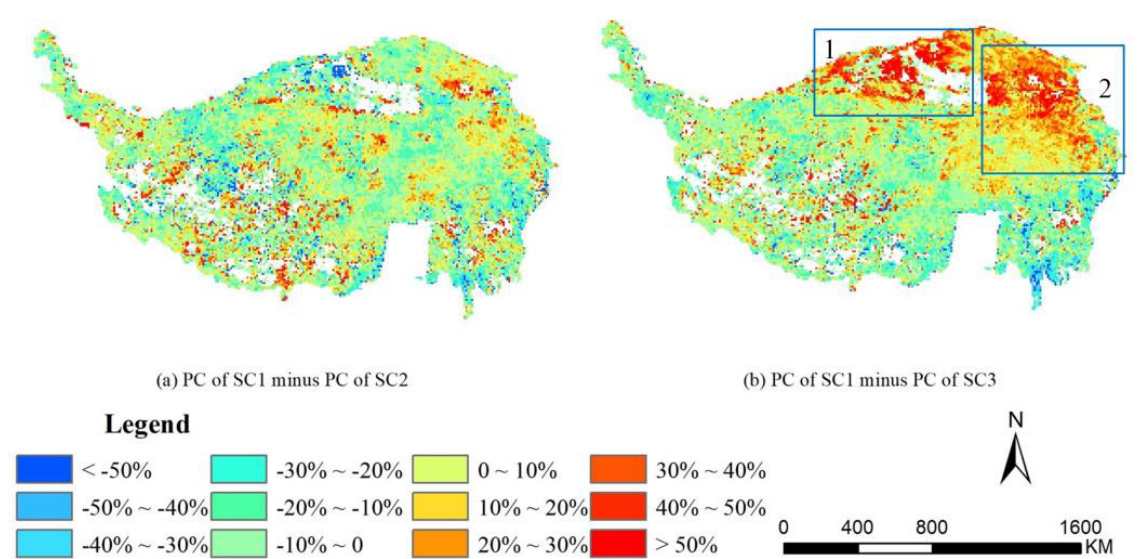
Figure 5. Spatial distribution of precision (PC) differences for cloud-gap-filled snow cover at the resolution of 10 × 10 km. SC1, SC2, and SC3 were the snow cover products of the combined MOD10A1F and MYD10A1F (SC1) developed by Huang et al. [28] and Qiu et al. [29], respectively. For RC, the number of grids with high values in SC1 was evidently higher than in SC2 and SC3 (Figures 6 and S3). There were four regions in SC2 (black frames 1, 2, 3, and 4 in Figures 6a and S3a) and three regions in SC3 (black frames 5, 6, and 7 in Figures 6b and S3b), where RC was lower than SC1. For SC2, the first region was in the Qaidam Basin (black frame 1), the second region was between the Qaidam Basin and Tanggula Mountains (black frame 2), the third region was southwest of the QTP, including the mountains of Tanggula and Gangdese (black frame 3), and the fourth region was in the Hengduan Mountains on the eastern edge of the QTP (black frame 4). For SC3, the regions were the same as for SC2, except for the first one (black frame 1).